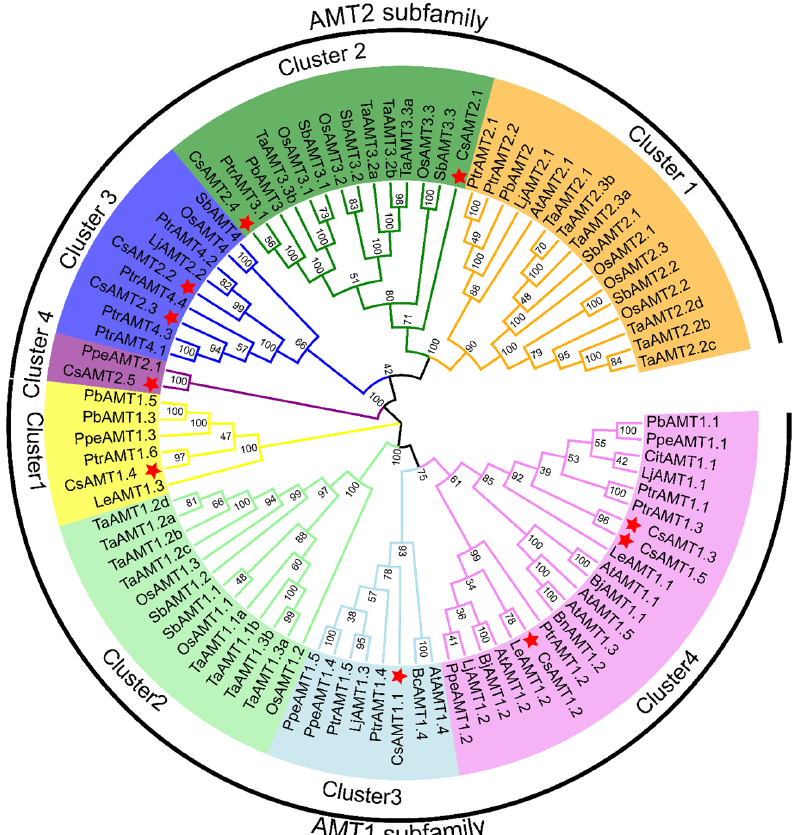
Figure 3. Phylogenetic analysis of proteins encoded by CsAMTs and AMTs from other plant species.